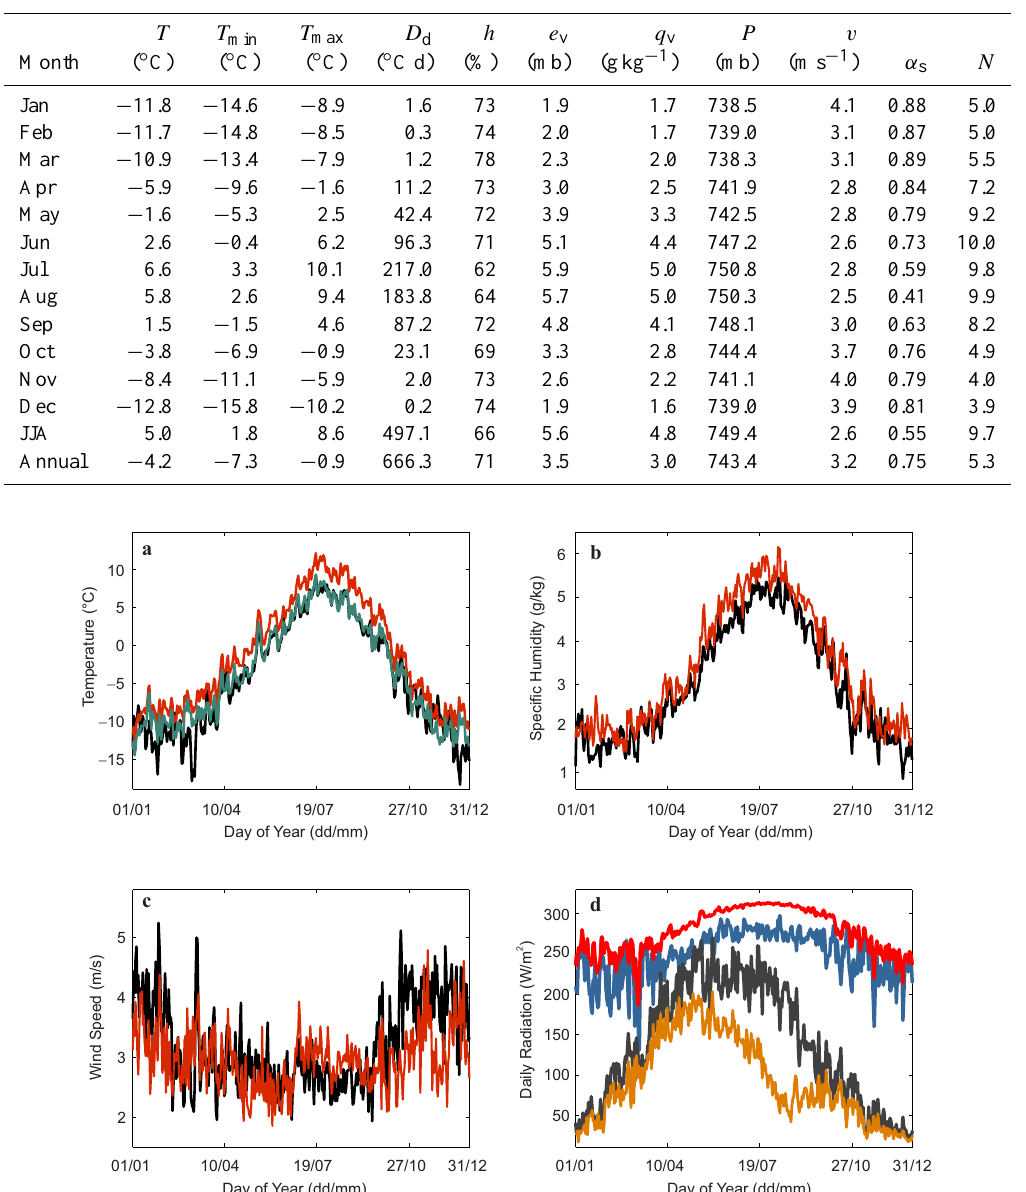
Table 4. Mean monthly weather conditions at Haig Glacier, Canadian Rocky Mountains, 2002–2012, as recorded at an automatic weather station at 2665m. N is the number of months with data in the 11-year record. Values are averaged over N months.